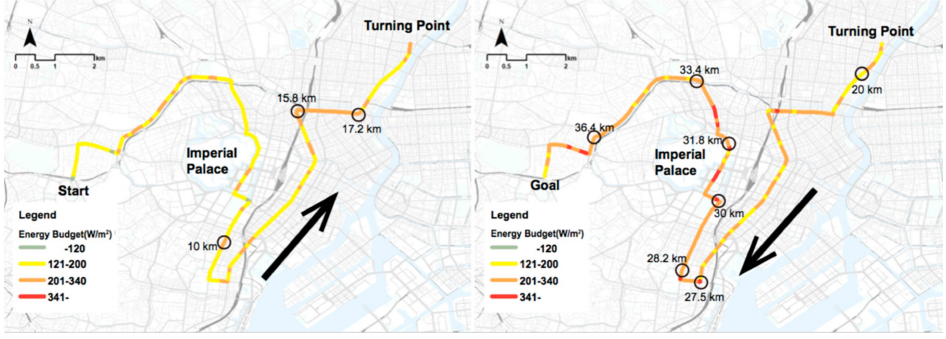
Figure 9. Energy budget for August 25, 2016 mapped on the marathon route (left: outward; right: homeward).